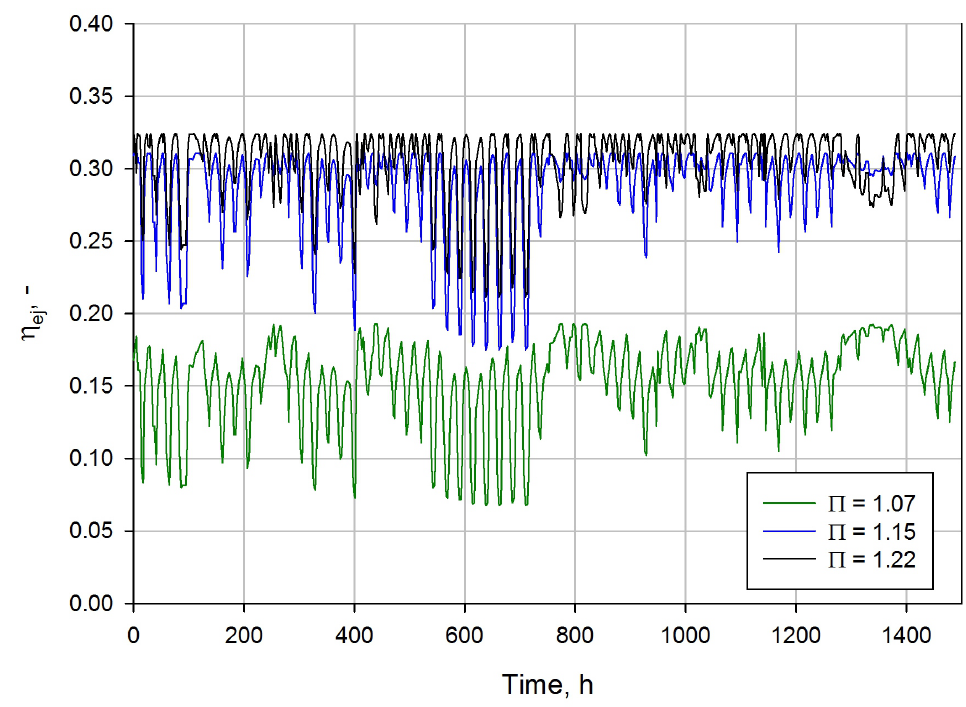
Figure 11. The ejector efficiency at different pressure ratios during the summer campaign in the South Asia region.